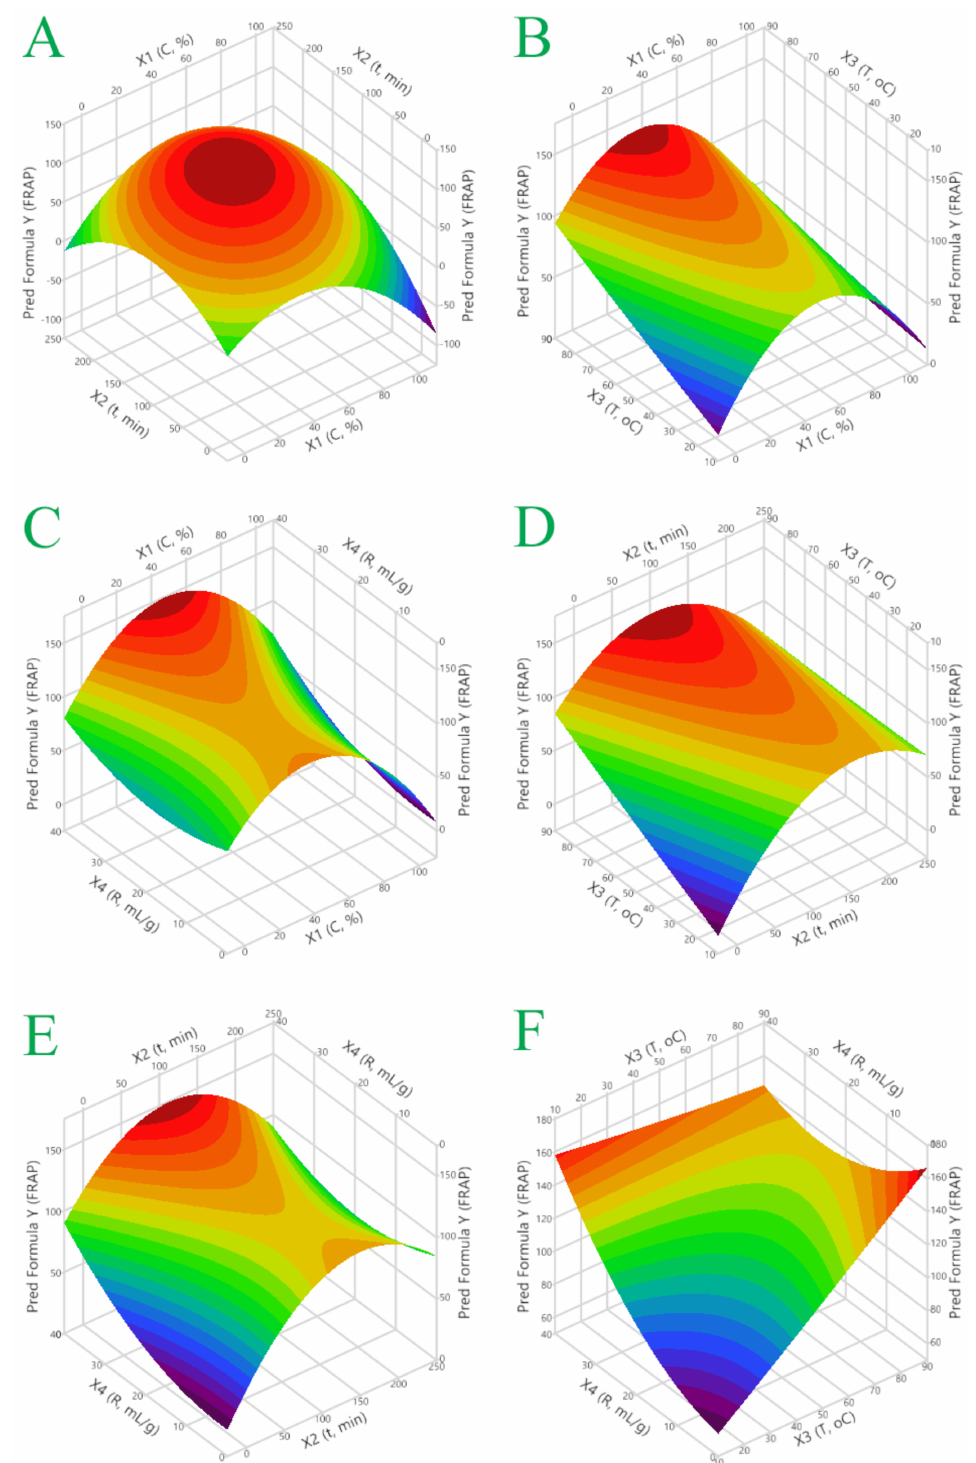
Figure 3. 3D graphs depicting the effect of the process variables considered on the response (FRAP, µ moL AAE/g), for the optimization of spent coffee grounds extraction performed with hydroethano- lic solutions. Plot ( A ), covariation of X 1 ( C , %) and X 2 ( t , min); plot ( B ), covariation of X 1 ( C , %) and X 3 ( T , ◦ C); plot ( C ), covariation of X 1 ( C , %) and X 4 ( R , mL/g); plot ( D ), covariation of X 2 ( t , min) and X 3 ( T , ◦ C); plot ( E ), covariation of X 2 ( t , min) and X 4 ( R , mL/g); plot ( F ), covariation of X 3 ( T , ◦ C) and X 4 ( R ,